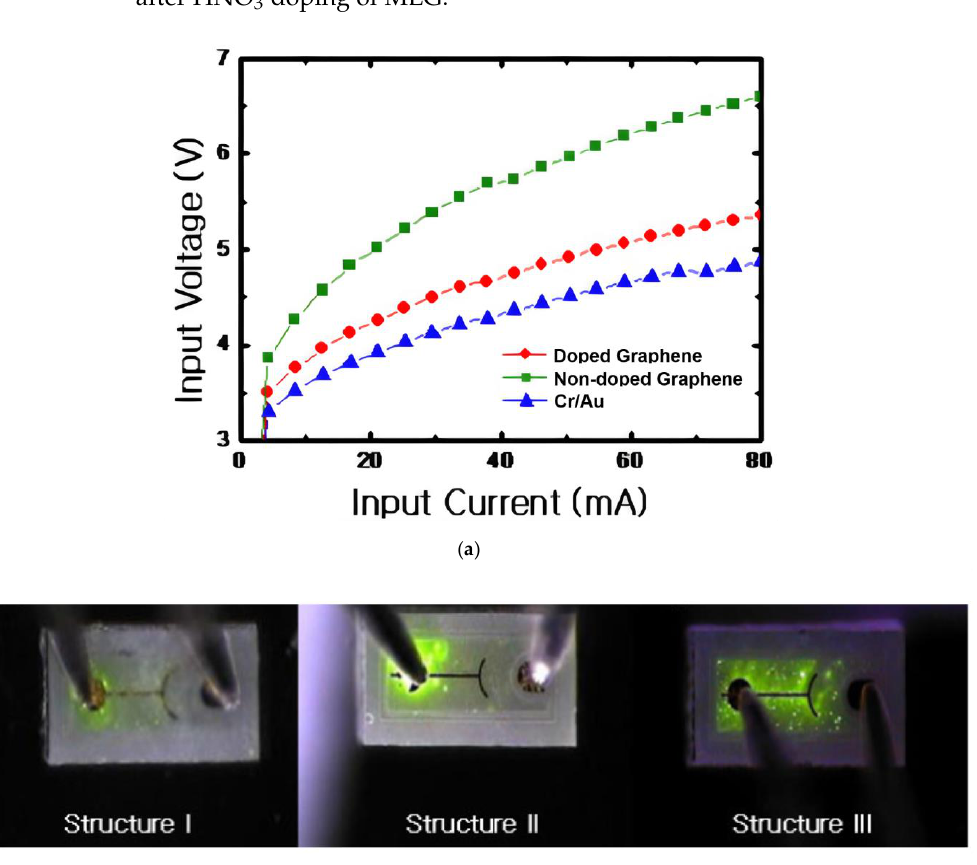
Figure 8. Graphene doped by HNO 3 acid as TCSL integrated into GaN-based LEDs: ( a ) I-V charac- teristic and ( b ) light emission images at an injection current of 5 mA with three different p-contacts: Cr/Au without TCSL (blue triangles and structure I), Cr/Au/graphene (green squares and structure II) and Cr/Au/doped graphene (red dots and structure III). Reproduced with permission from [98]. Copyright 2013 IOP Publishing